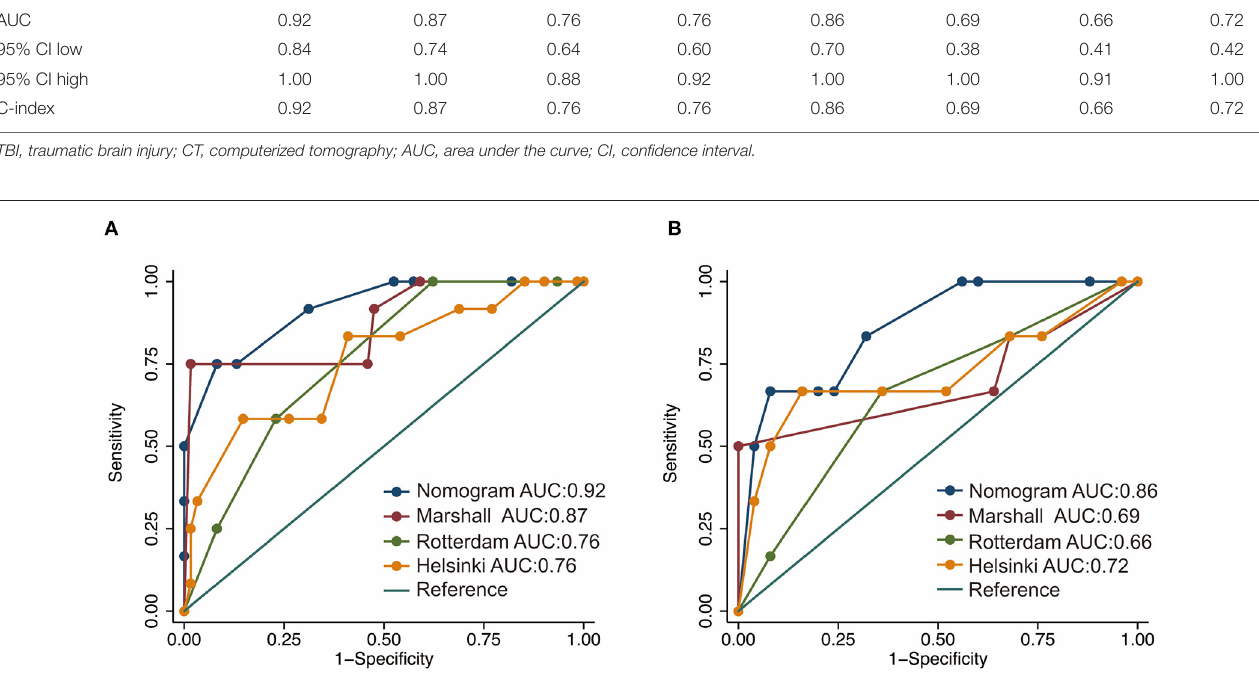
FIGURE 3 | Receiver operating characteristic (ROC) curves of the nomogram and current CT scoring systems in the training (A) and validation cohorts (B)